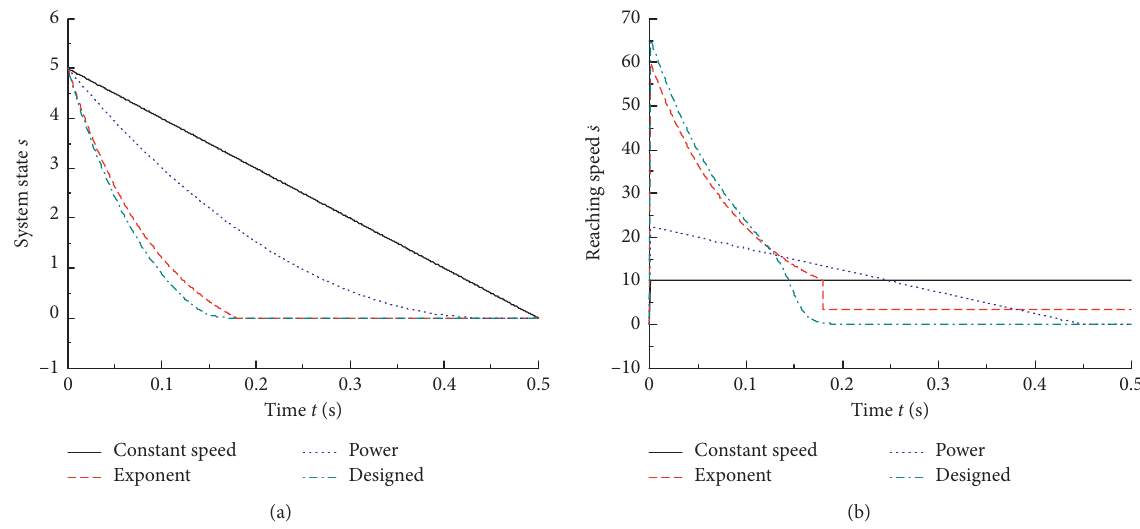
Figure 5: New reaching curves and approach speed when s � 5. (a) New reaching curves when s � 5. (b) New reaching speed when s �